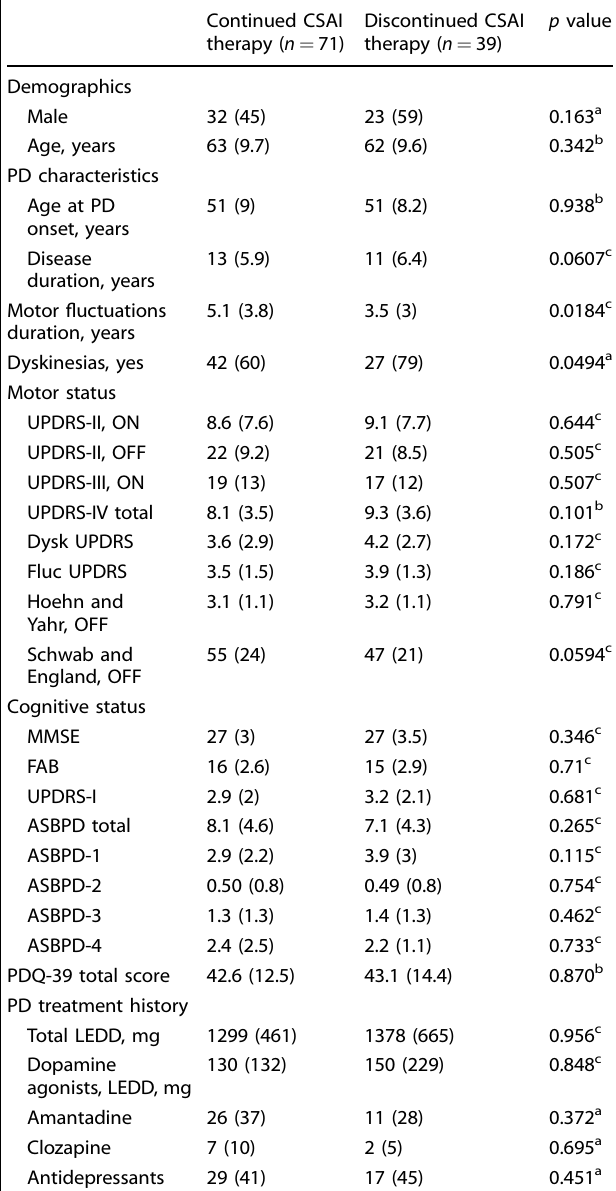
Table 1. Baseline